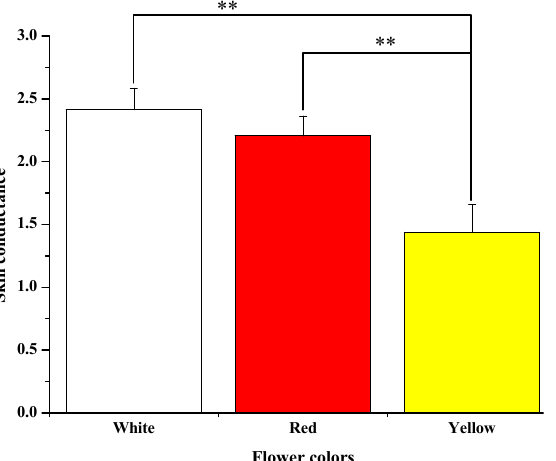
Figure 7. Average of skin conductance values recorded while seeing of rose colors (white, red, and yellow), ** p <0.01.